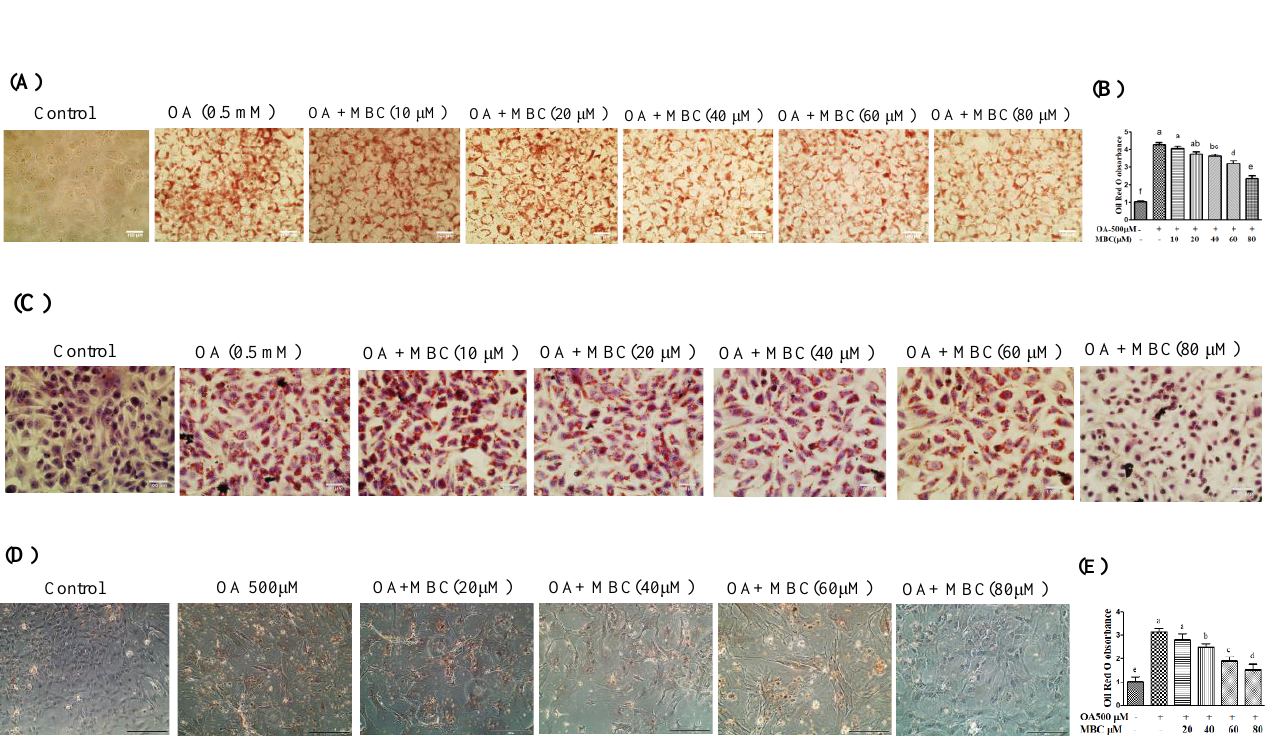
Figure 2. Effect of methyl brevifolincarboxylate (MBC) on OA-induced intracellular lipid accumulation in SK-HEP-1 cells and primary murine hepatocytes. Cells were plated into 12 well plate dishes and treated with different doses of MBC (as indicated in the figure) in the presence of OA (0.5 mM) for 48 h. ( A ) SK-HEP-1 cells were stained with Oil Red O. ( B ) Quantitative data for lipid accumulation in SK-HEP-1 cells (Oil Red O staining). ( C ) H&E staining of OA and MBC-treated SK-HEP-1 cells. ( D ) Primary murine hepatocytes were stained with Oil Red O. ( E ) Quantitative data for lipid accumulation in primary murine hepatocytes (Oil Red O staining). Scale bar = 100 µm. The results were expressed as mean ± SD from three independent experiments. Data bars with similar letters were not significantly different ( p < 0.05).